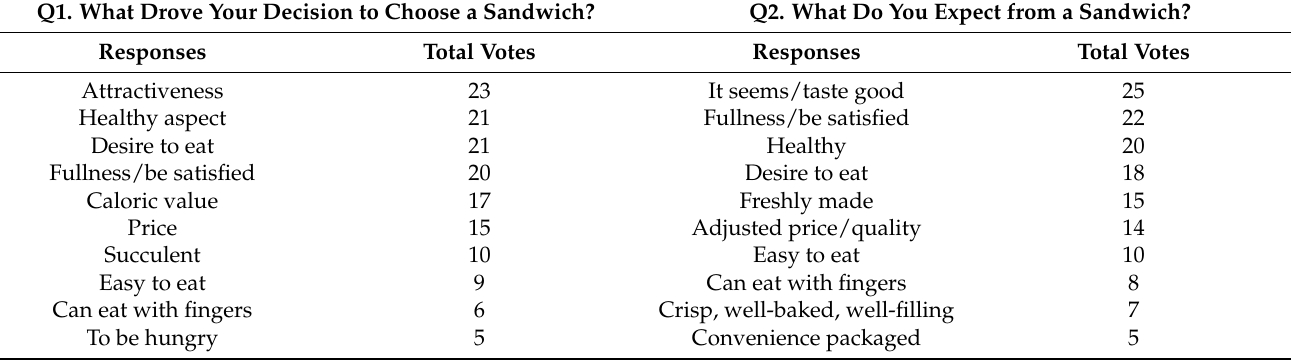
Table 2. Nominal group technique: Top 10 responses to the questions Q1 and Q2 Q1. What Drove Your Decision to Choose a